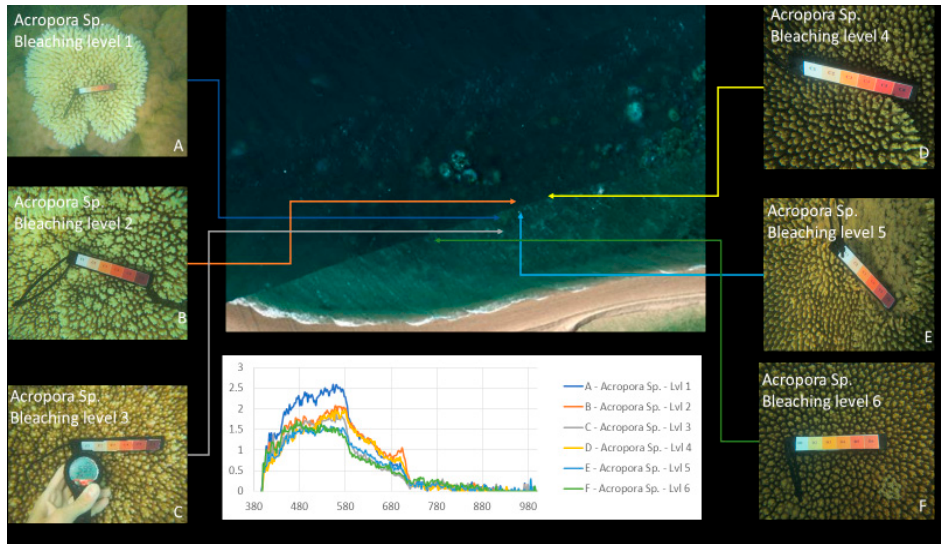
Figure 9. Examples of spectral responses “fingerprints” of bleaching levels 1 to 6 for Acropora coral.